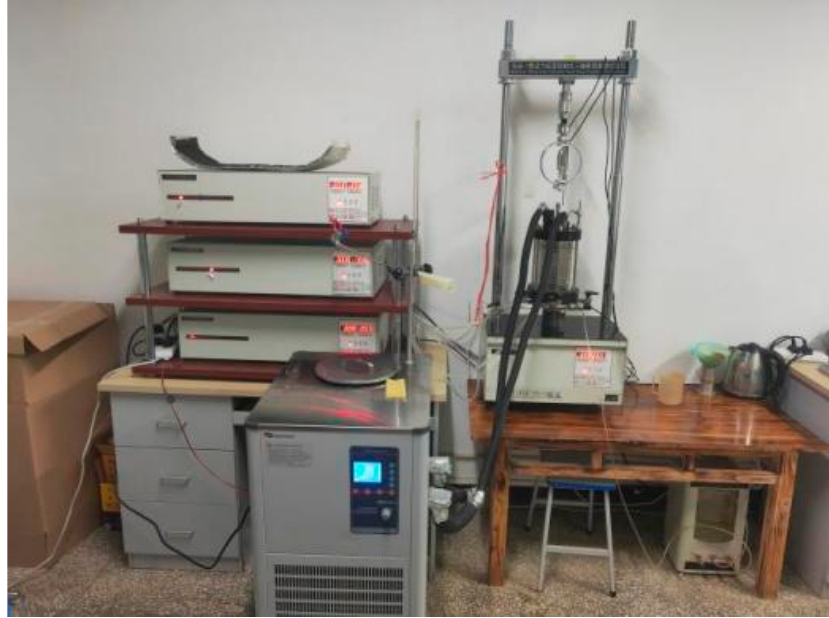
Figure 1. Temperature-controlled SLB-1 type stress–strain controlled triaxial shear penetration tester.